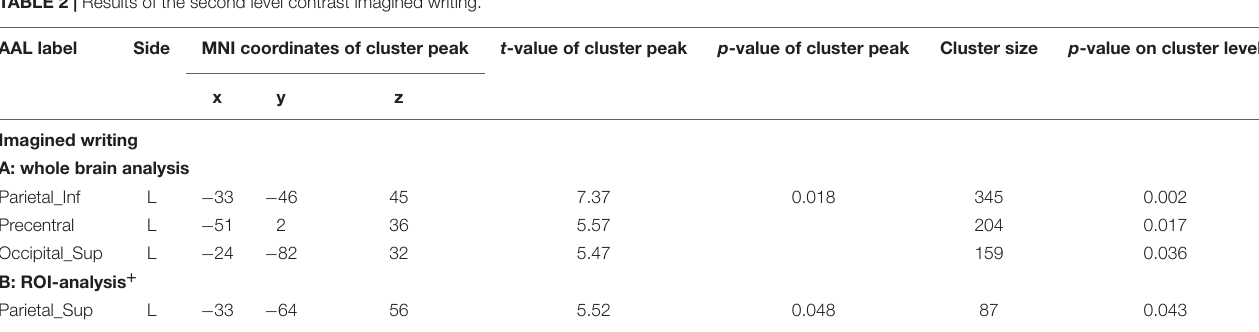
FIGURE 3 | T-maps for writing compared to drawing. Parts of the precentral (blue contour) and postcentral (red contour) gyrus showed a stronger BOLD response on writing compared to drawing. The contours refer to the respective regions of the AAL atlas. Clusters are significant within the ROI analysis after FWE-correction on p < 0.05. M1, primary motor cortex; S1, primary somatosensory cortex. TABLE 2 | Results of the second level contrast imagined